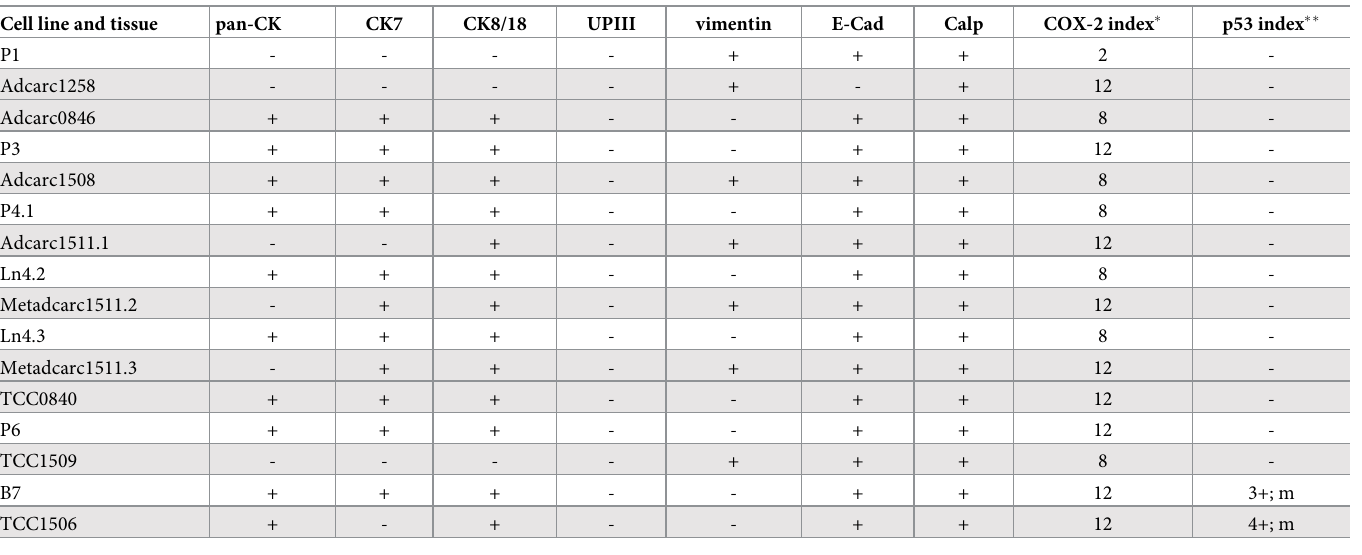
Table 2. Comparative immunohistochemical staining of cell lines and original tumor tissues. Cell line and tissue